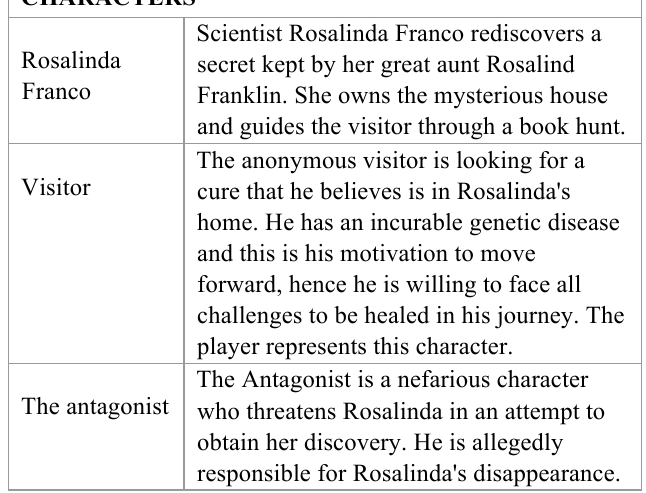
Table 2. Project GDD section drawn up by the students